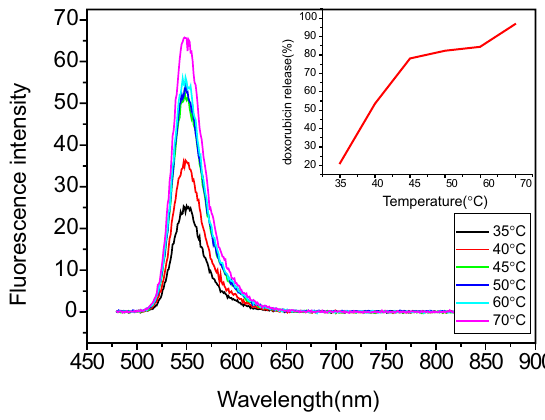
Fig. 5. Photothermal properties of the AuNR-HM-DOX microcapsules with di®erent temperatures.